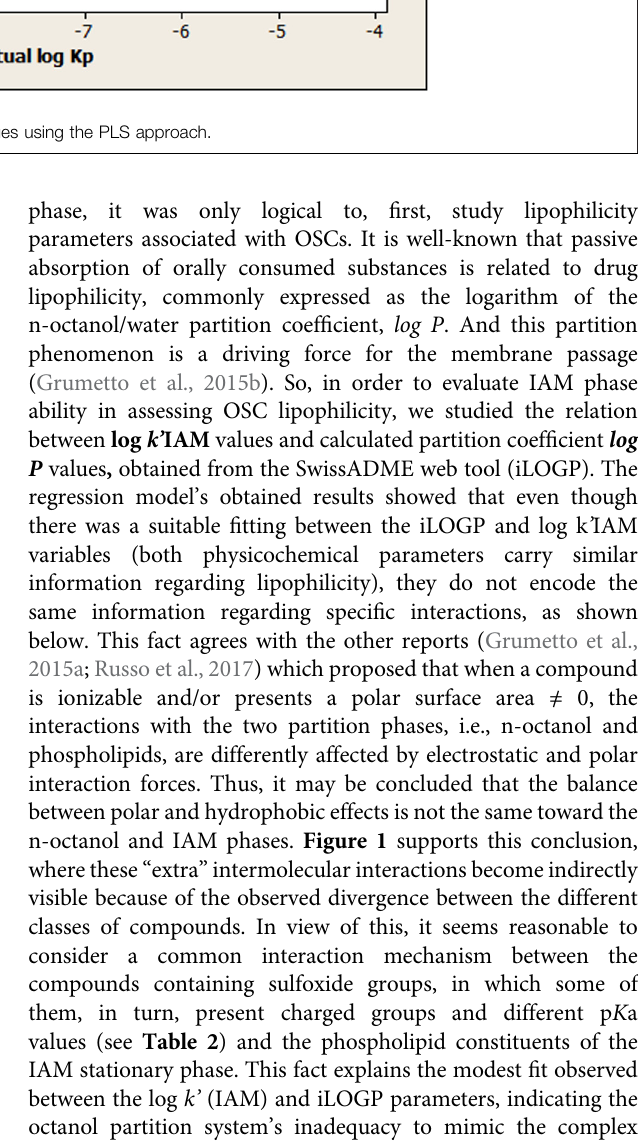
Frontiers in Chemistry |